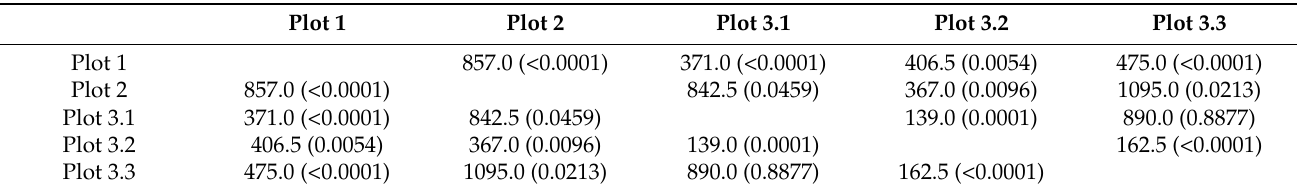
Table 4. Significance of differences ( U ( p )) in helminth infestation of Pelophylax lessonae . Plot 1 Plot 2 Plot 3.1 Plot 3.2 Plot 3.3 Plot 1 857.0 (<0.0001) 371.0 (<0.0001) 475.0